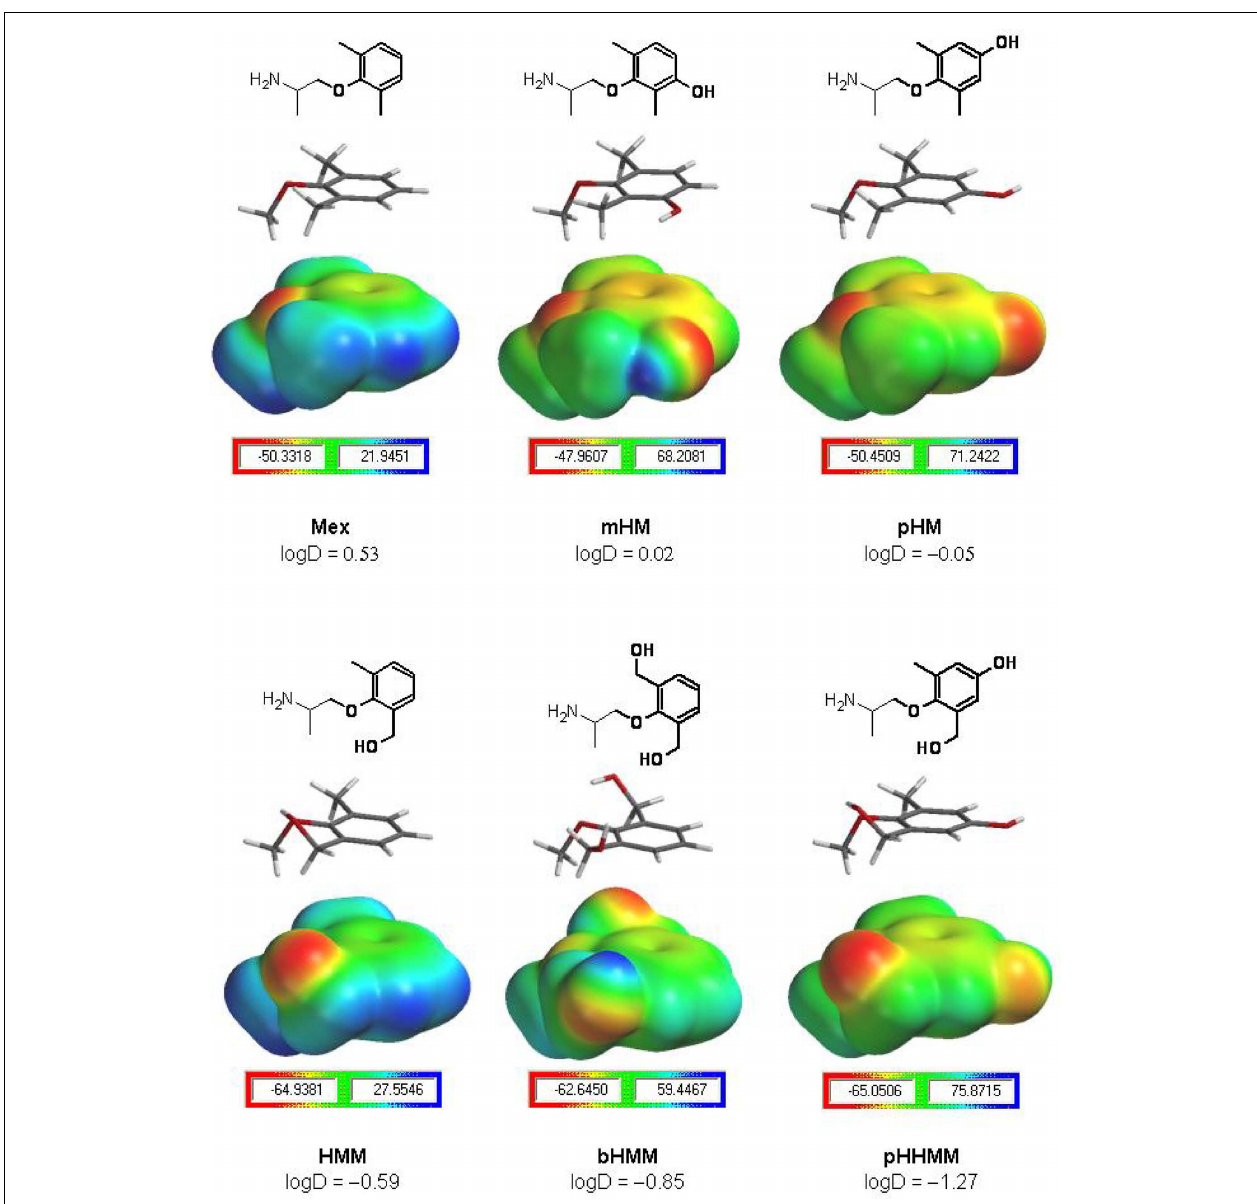
the one used in structure–activity evaluations.The HMM, bHMM, and pHHMM moieties (lower half of the figure) presented the most negative electrostatic potential values (around − 65kcal/mol), which most likely may allow less favorable interactions with electron-rich aromatic rings (e.g., F1586 orY1593 rings), compared to the ones expected for Mex, mHM, and pHM moieties with a less negative electrostatic potential (around − 50kcal/mol). The Log D values experimentally measured at pH 7.4 are